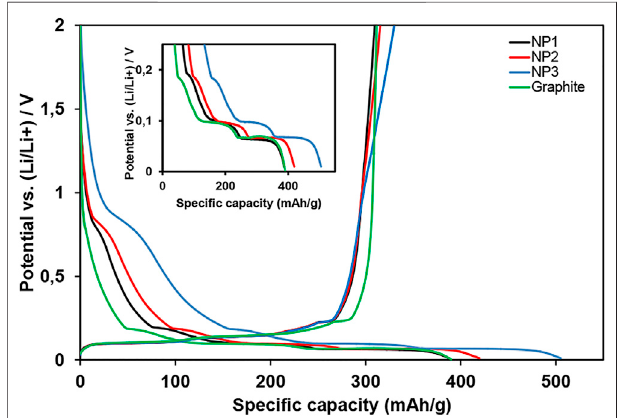
FIGURE 4 | First discharge and charge curves at a current rate of C/20 for graphite and three graphene-based electrodes evaluated. Flat plateaus below ~0.25 V (vs. Li/Li + ) are zoomed in as an inset. Note: 10 wt% of GNPs is used in graphene-based electrodes; the total active material is 94.5